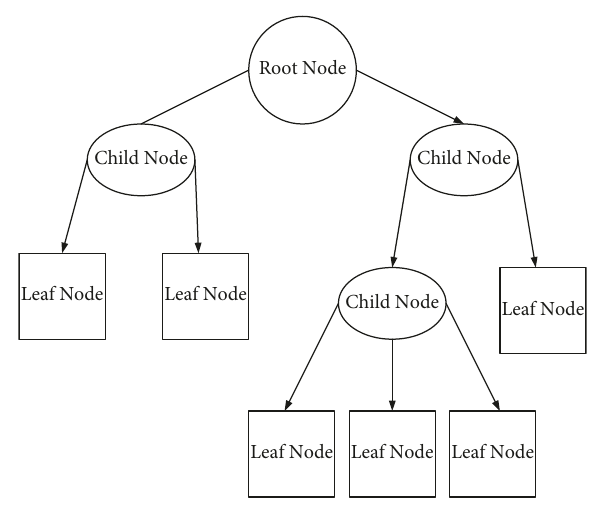
Figure 3: Topological structure of the decision